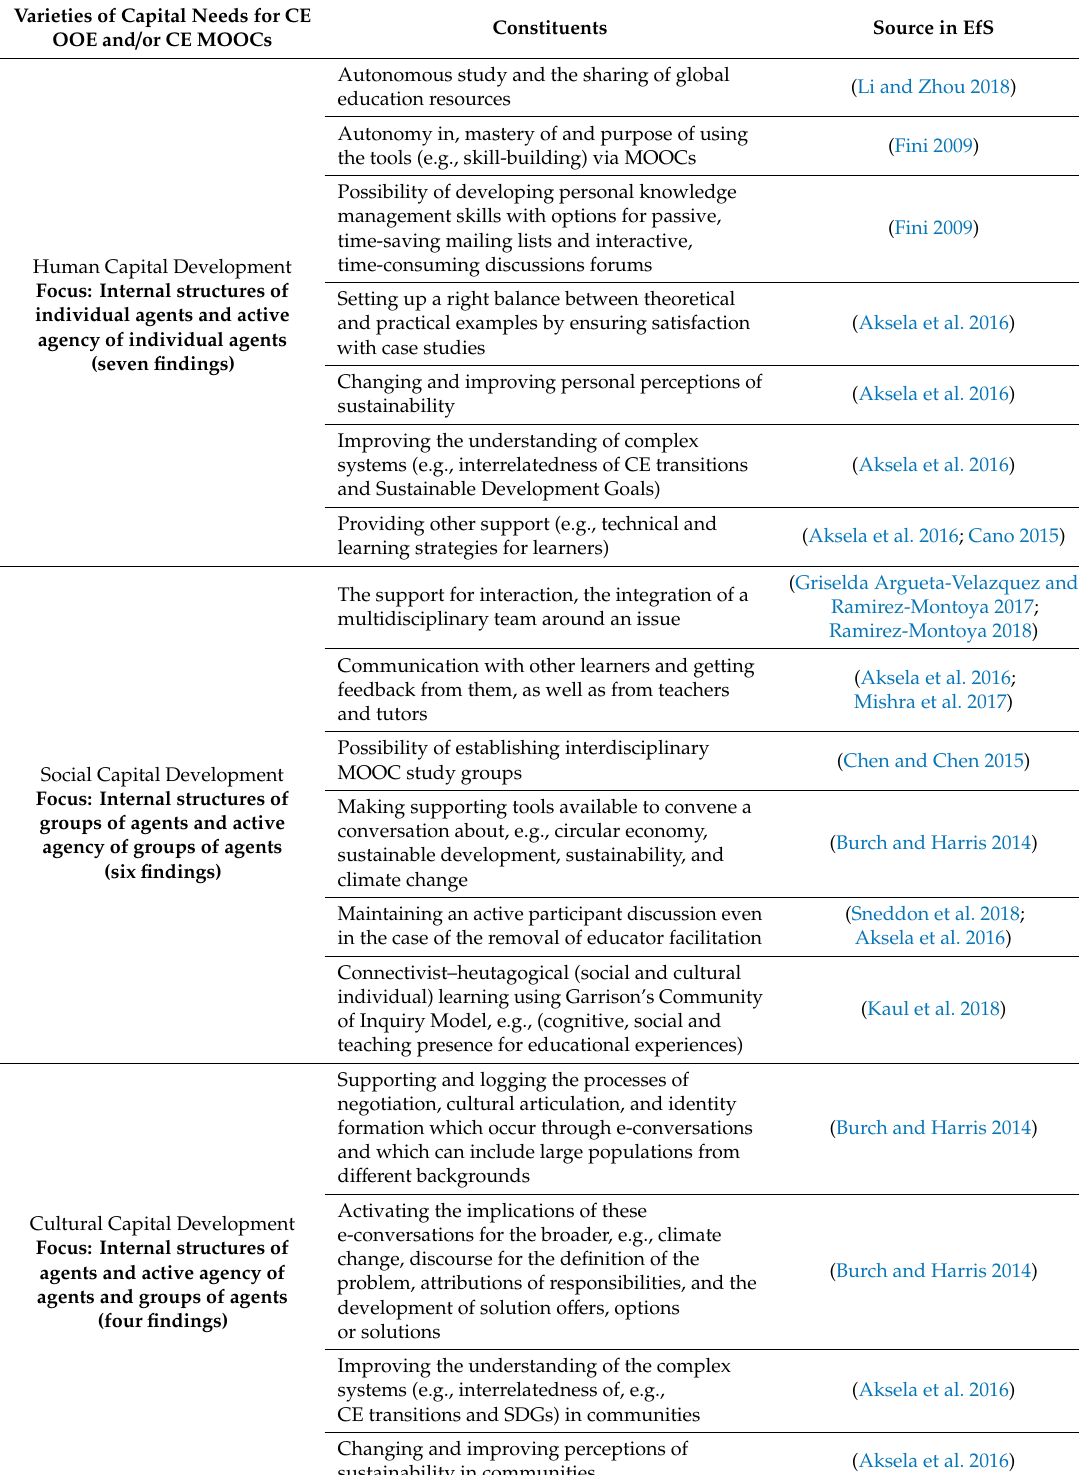
Table 1. Structuration constituents among classical capital and